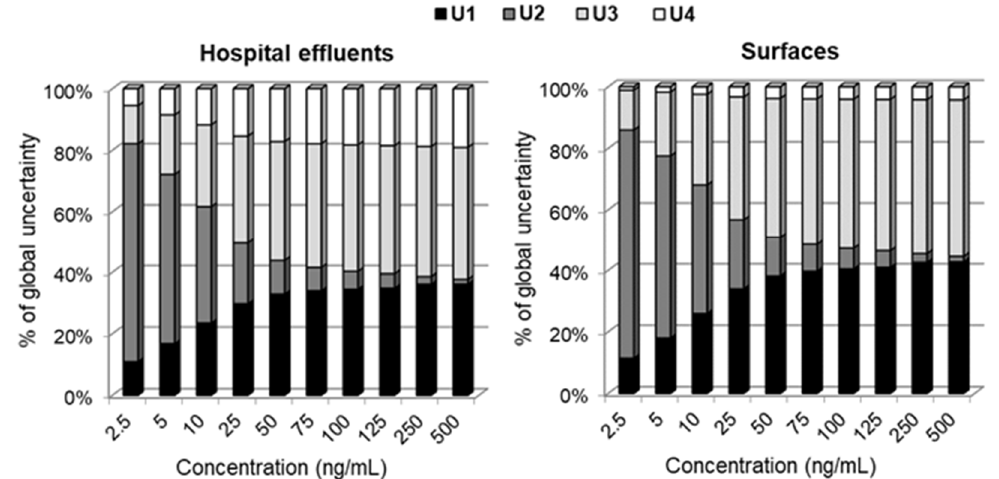
Figure 3. Relative weight of each individual source of uncertainty (bottom-up approach/EURACHEM) for bicalutamide quantification in hospital effluents and surfaces by HPLC–FLD. U1—uncertainty associated with standard preparation; U2—uncertainty associated with the calibration curve; U3—uncertainty associated with precision; U4—uncertainty associated with accuracy. 50 ng/mL corresponds to 100 pg/cm 2 in the case of surface samples.